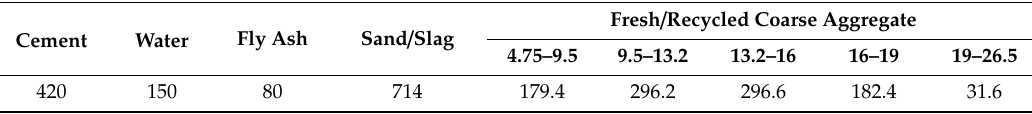
Table 4. Concrete material scale (kg / m 3 ).